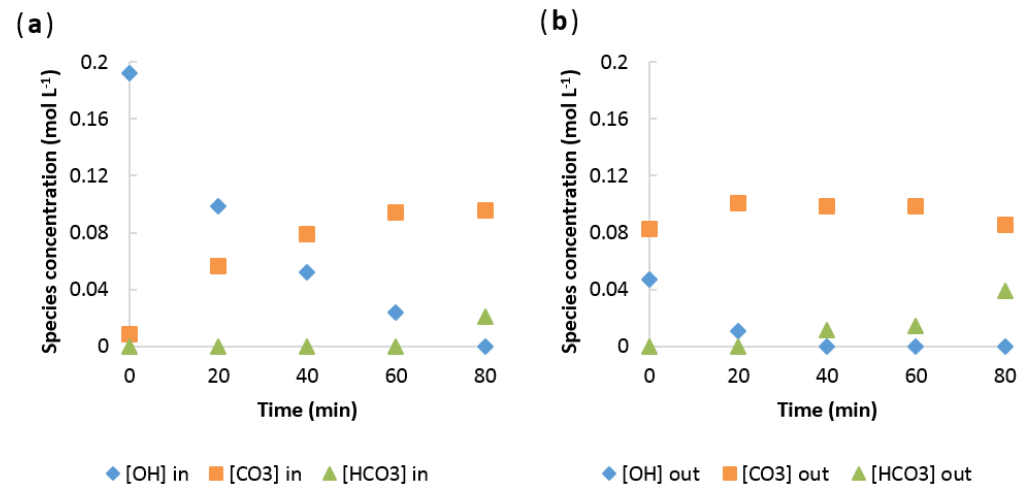
Figure 2. Evolution of inlet ( a ) and outlet ( b ) species concentration as a function of time in the packed column. CO 2 and NaOH initial concentrations are 10% and 0.2 mol L −1 , respectively; gas and liquid flow rates are 33 and 1 L min −1 ; respectively.